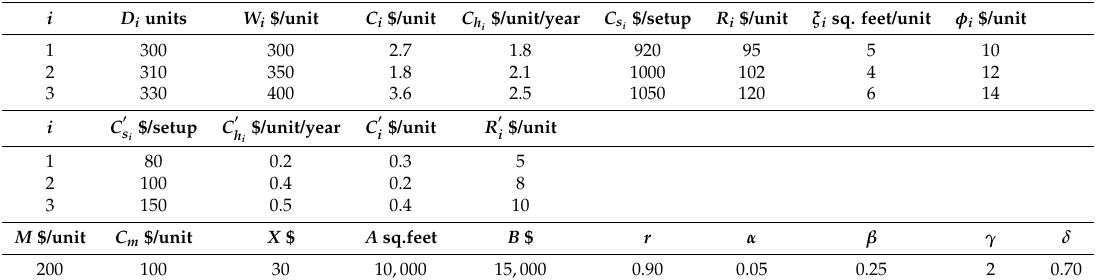
Table 4. Input parameters for i = 3.